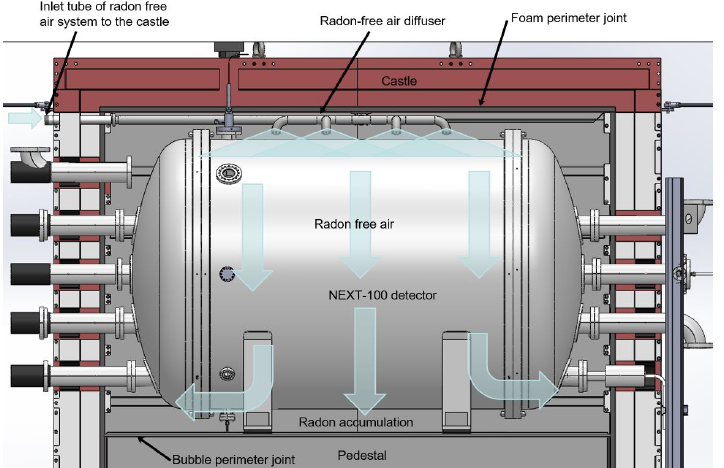
Figure 12. Side view of the Rn-free air diffusor, the Castle and the NEXT100 detector. We show an upper cut (without the roof of the Castle) of the diffusor and the NEXT-100 vessel in Figure 13. The flows of injected air from the 8 tubes of the diffusor were marked with blue circles, above the detector. The Castle (in red) is divided into two mobile parts. Both sides are independent and can be moved to get access to the detector. For this purpose, a system with rails, wagon wheels, and two electric motors to open and close the Castle was